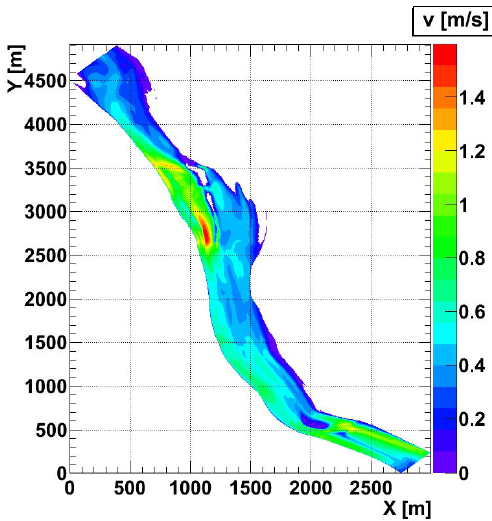
Fig. 2. The water depth for the considered reach of the Vistula River, computed for the averaged low-flow discharge.